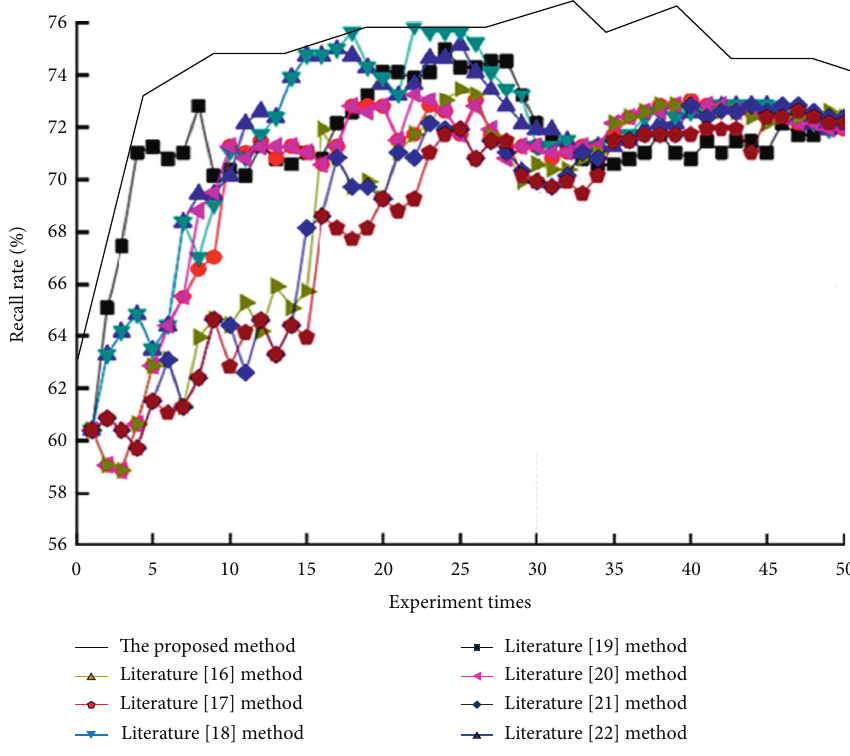
Figure 11: Recall rate